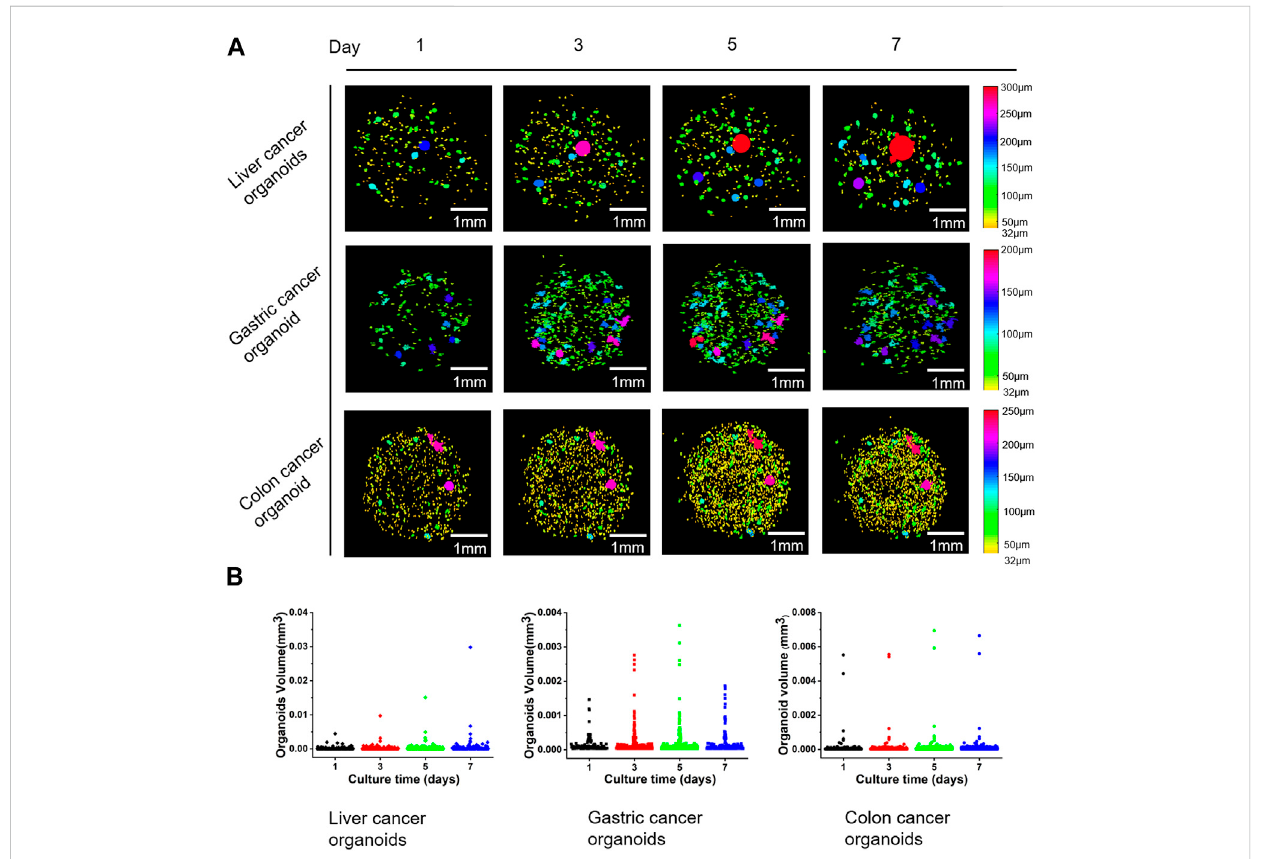
FIGURE 6 Examples of the changes of three different types of organoids over time and scatter plots of organoid volumes. (A) Three-dimensional reconstruction results of organoid volume changes over time for three types of liver, gastric, and colon cancers. (B) Scatter plots corresponding to the volume of the organoids in (A)